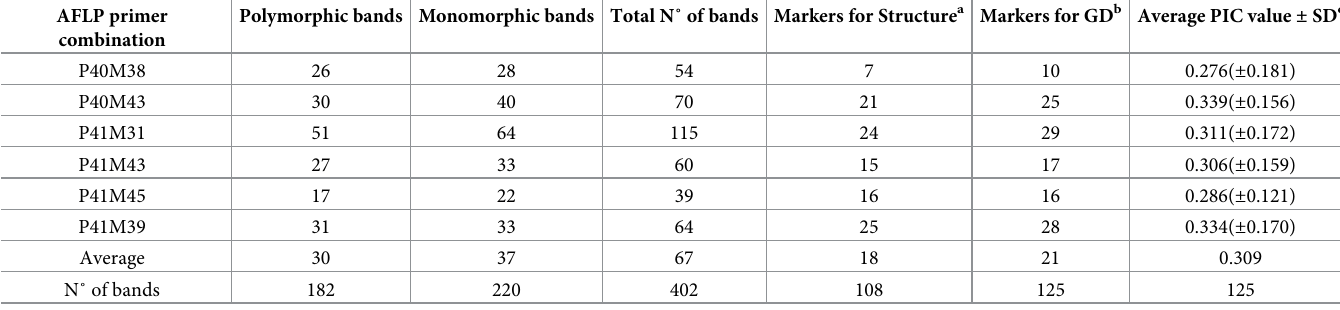
Table 3. Description of the total AFLP loci analyzed per primer combination. AFLP primer